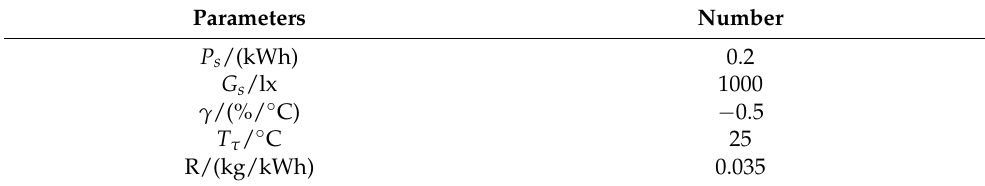
Table A3. Photovoltaic cell